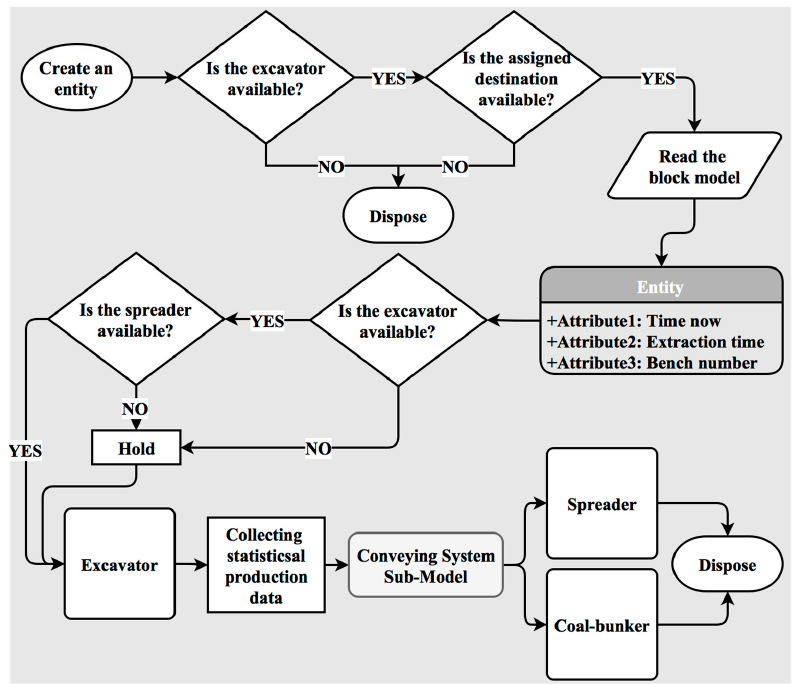
Figure 10 . Flowchart of the main logic behind the simulation model. Figure 10. Flowchart of the main logic behind the simulation